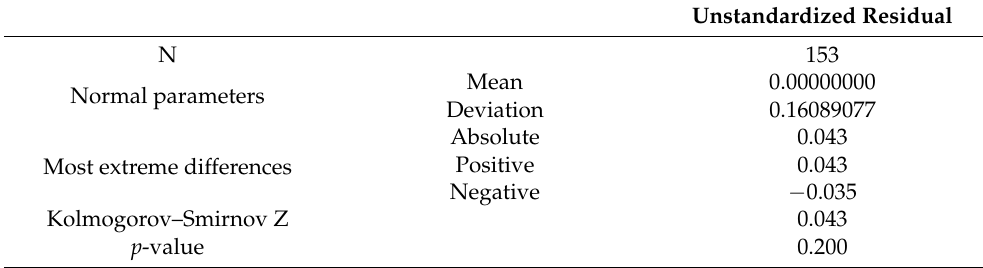
Table 6. K-S Test